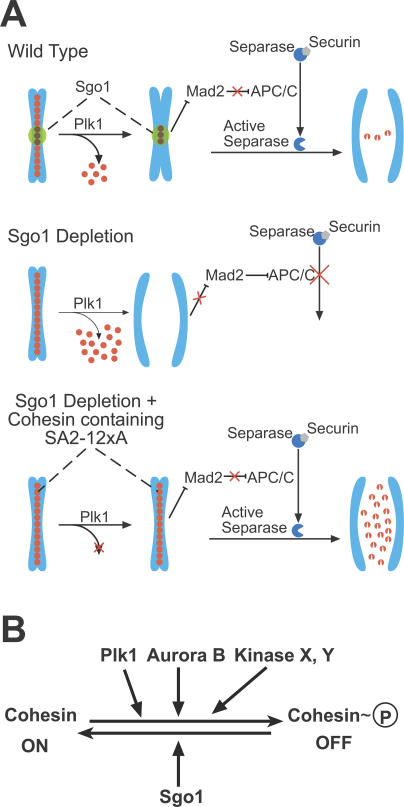
Model for Sgo1 Function during Mitosis(A) During an unperturbed mitosis (Wild Type), arm cohesin (red circles) is removed in a kinase-dependent manner during prophase/prometaphase. Sgo1 protects centromeric cohesin (brown circles) until the metaphase-anaphase transition. Once all chromosomes have successfully bi-oriented on the metaphase plate, Mad2 inhibition of the APC/C is relieved, allowing separase activation. Separase in turn removes cohesin remaining at centromeres through cleavage of the α kleisin Scc1 subunit, allowing the cell to enter anaphase. In the absence of Sgo1 (Sgo1 Depletion), cohesin is removed from the chromosome arms and at the centromere during prophase/prometaphase before chromosomes have properly bi-oriented and been attached to their full complement of spindles. Thus, Mad2 activity continues to maintain the spindle checkpoint, causing cells to arrest for a prolonged period in a prometaphase-like state with separated sister chromatids. Expression of nonphosphorylatable Scc3-SA2 (Sgo1 Depletion + Cohesin containing SA2–12xA) prevents the prophase removal of cohesin both from arms and centromeres, thus allowing cells to proceed through an apparently normal anaphase even in the absence of Sgo1 activity.(B) The phosphorylation state of cohesin may be the result of a dynamic balance in which Sgo1 somehow functions to antagonize the activity of mitotic kinases, including Plk1 and Aurora B and, potentially, other as-yet unidentified kinases (Kinase X, Y). In this model, when the direction of the reaction is artificially sent towards the hyperphosphorylated state (following Sgo1 knockdown), cohesin efficiently dissociates from chromatin; when the opposite state is favoured (e.g., as a result of Plk1 depletion) cohesin remains tightly associated with chromatin.